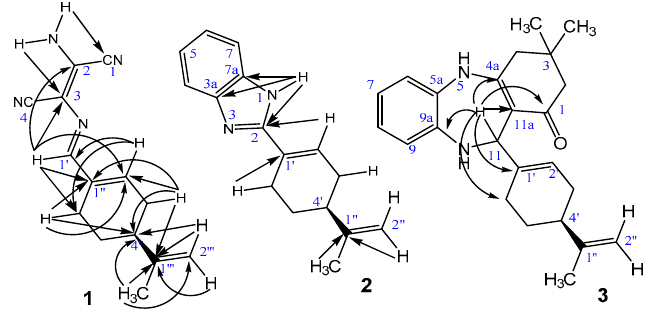
Figure 2. HMBC correlations of compound 1 – 3 .